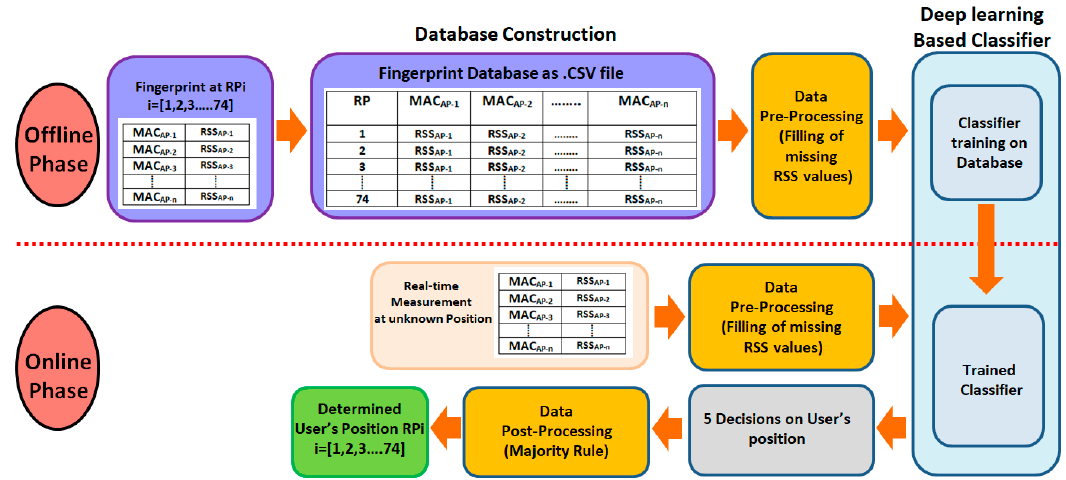
Figure 2. Proposed Wi-Fi fingerprint-based indoor positioning system equipped with data pre- and post-processing modules.